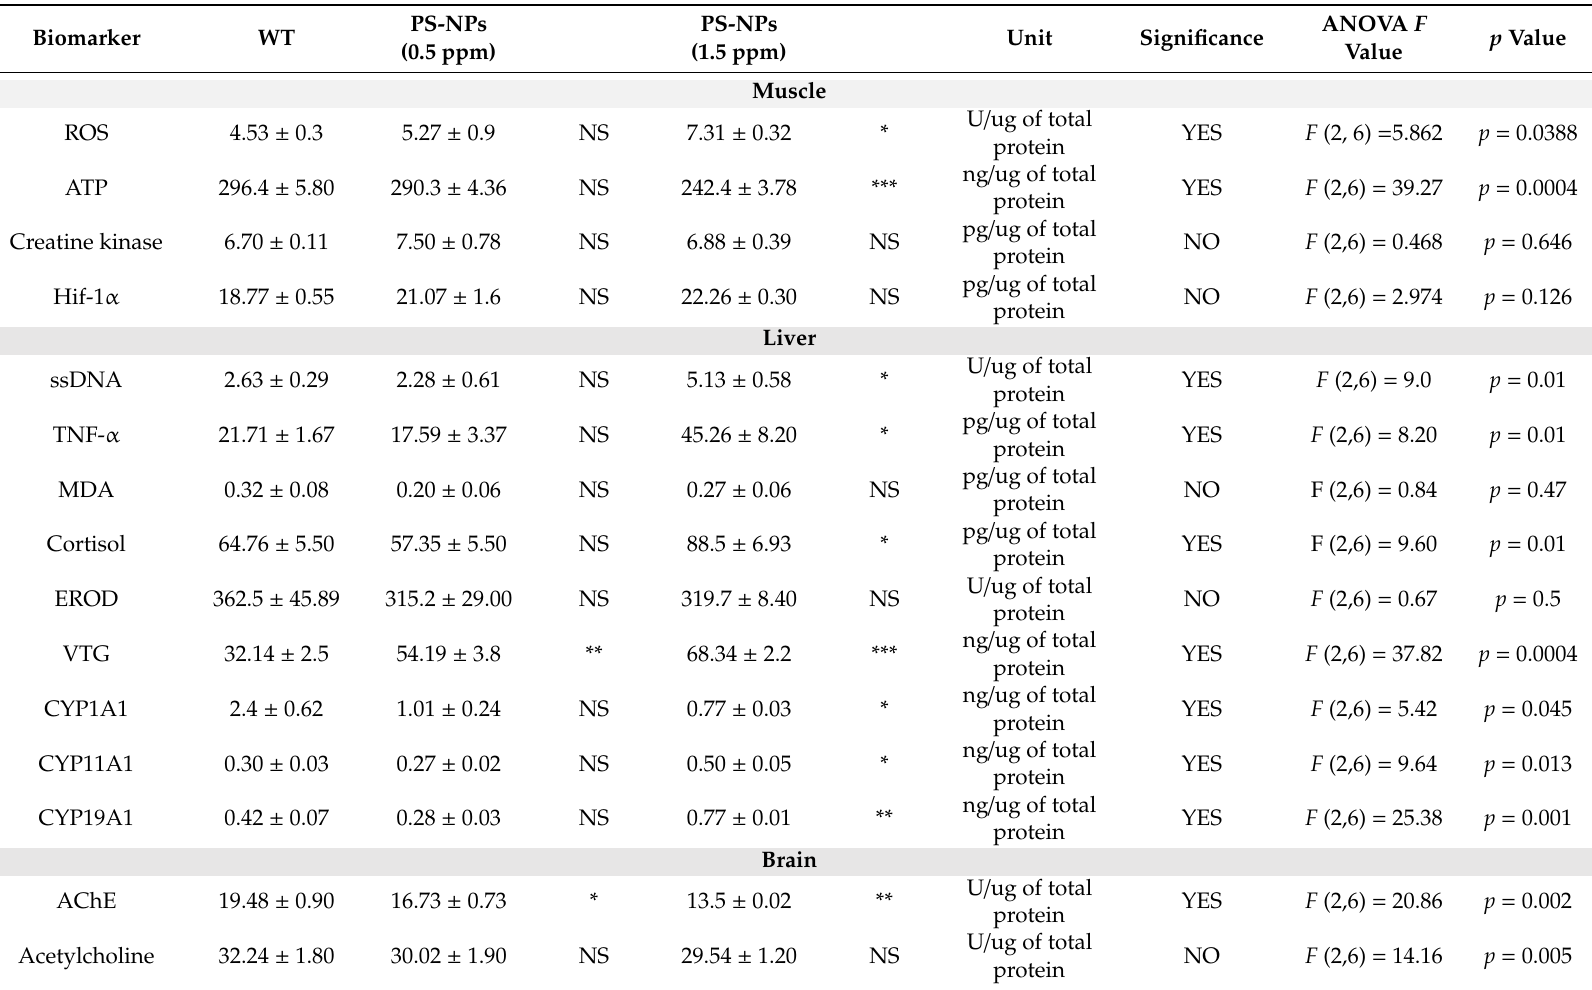
Table 1. Various biomarker analyses in the muscle, liver, and brain tissues for adult zebrafish exposed to low and high doses of polystyrene nanoparticles (PS-NPs). The data are expressed as the mean ± SEM and analyzed by One-way ANOVA continued with post hoc